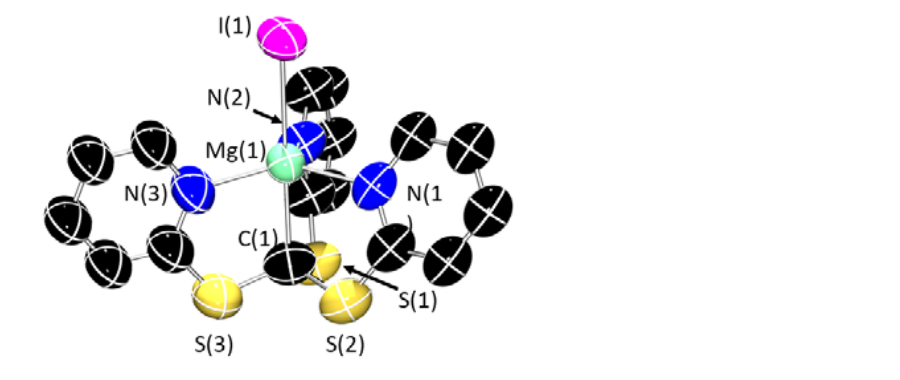
Figure 4. X-ray crystal structure of monomeric 1-I . Ellipsoids are set at 50% probability level, and hydrogen atoms have been excluded for clarity. C: black; N: blue; S: yellow; Mg: aquamarine; I: purple.